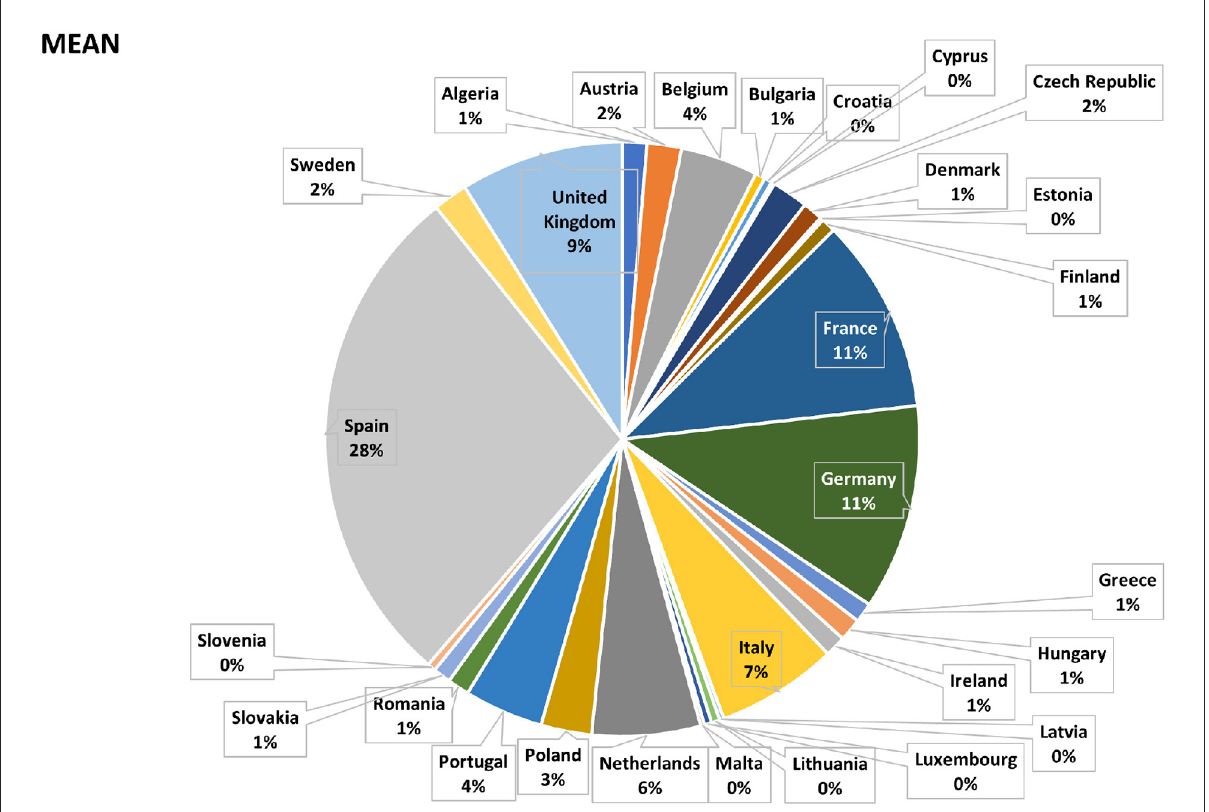
FIGURE7 Percentages of mean losses for 3 days of delay caused by a cyber-physical